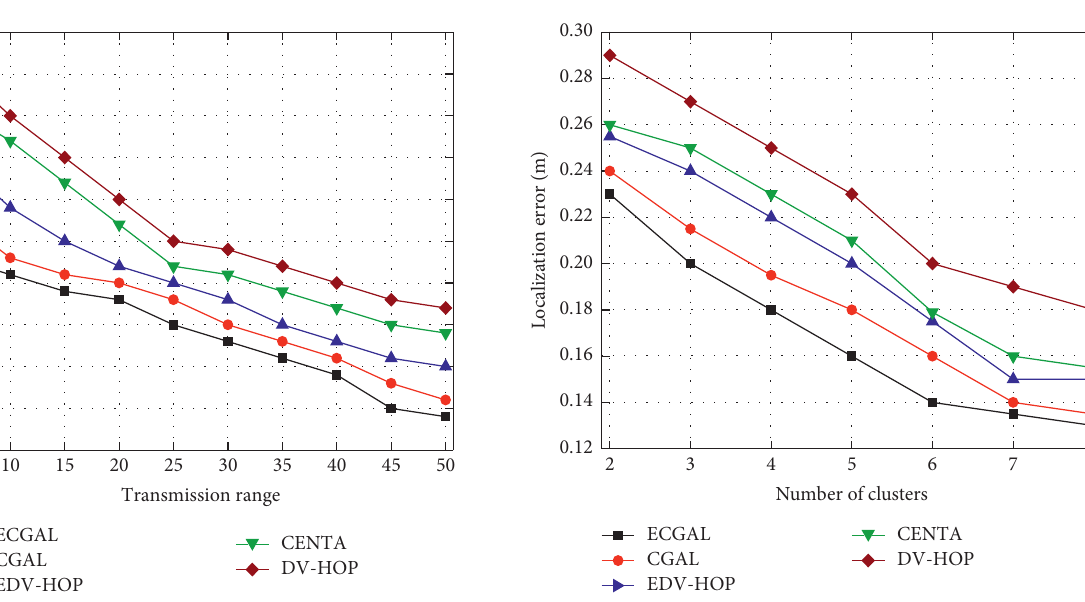
Figure 11: Localization error against transmission range. Figure 13: Localization error against the number of